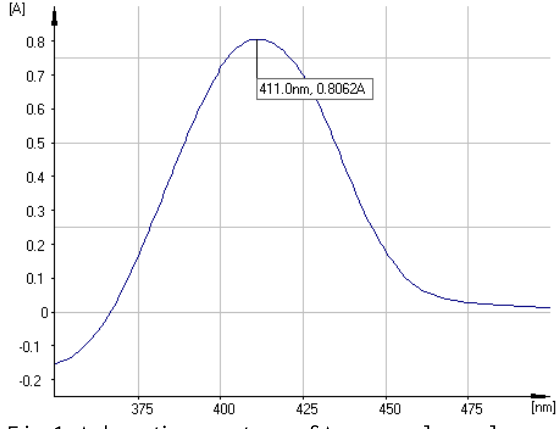
Fig. 1. Adsorption spectrum of Acorus calamus leaves